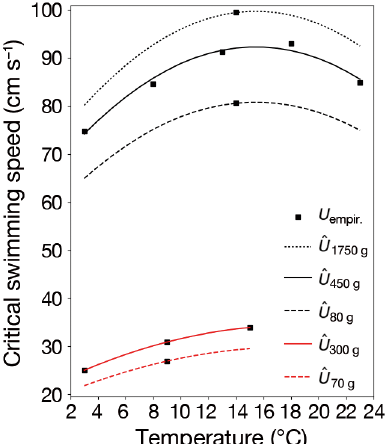
Fig. 3. Temperature-dependent critical swimming speed ( Û crit ) for Atlantic salmon (black lines) and lumpfish (red lines) of different sizes. The empirical critical swimming speed data ( U empir. ) for Atlantic salmon are from Hvas et